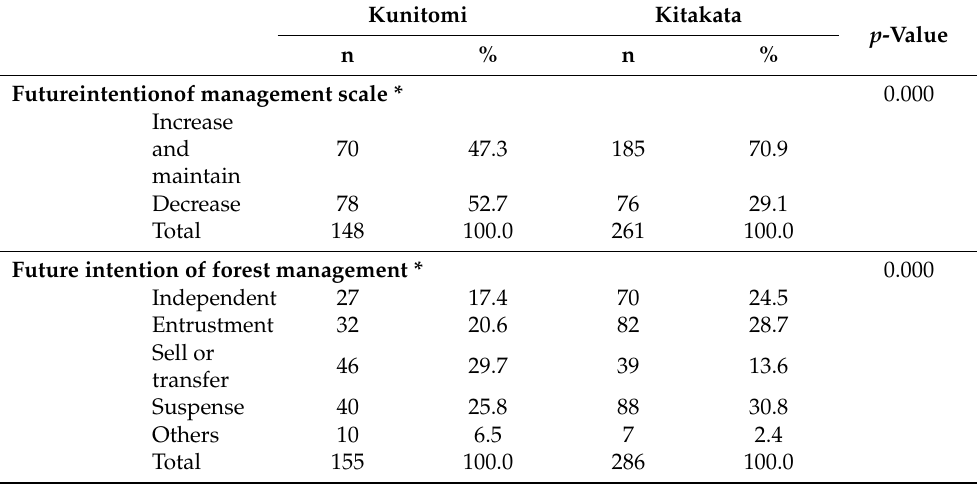
Table 1. Comparison of future intention to manage forests between two regions.